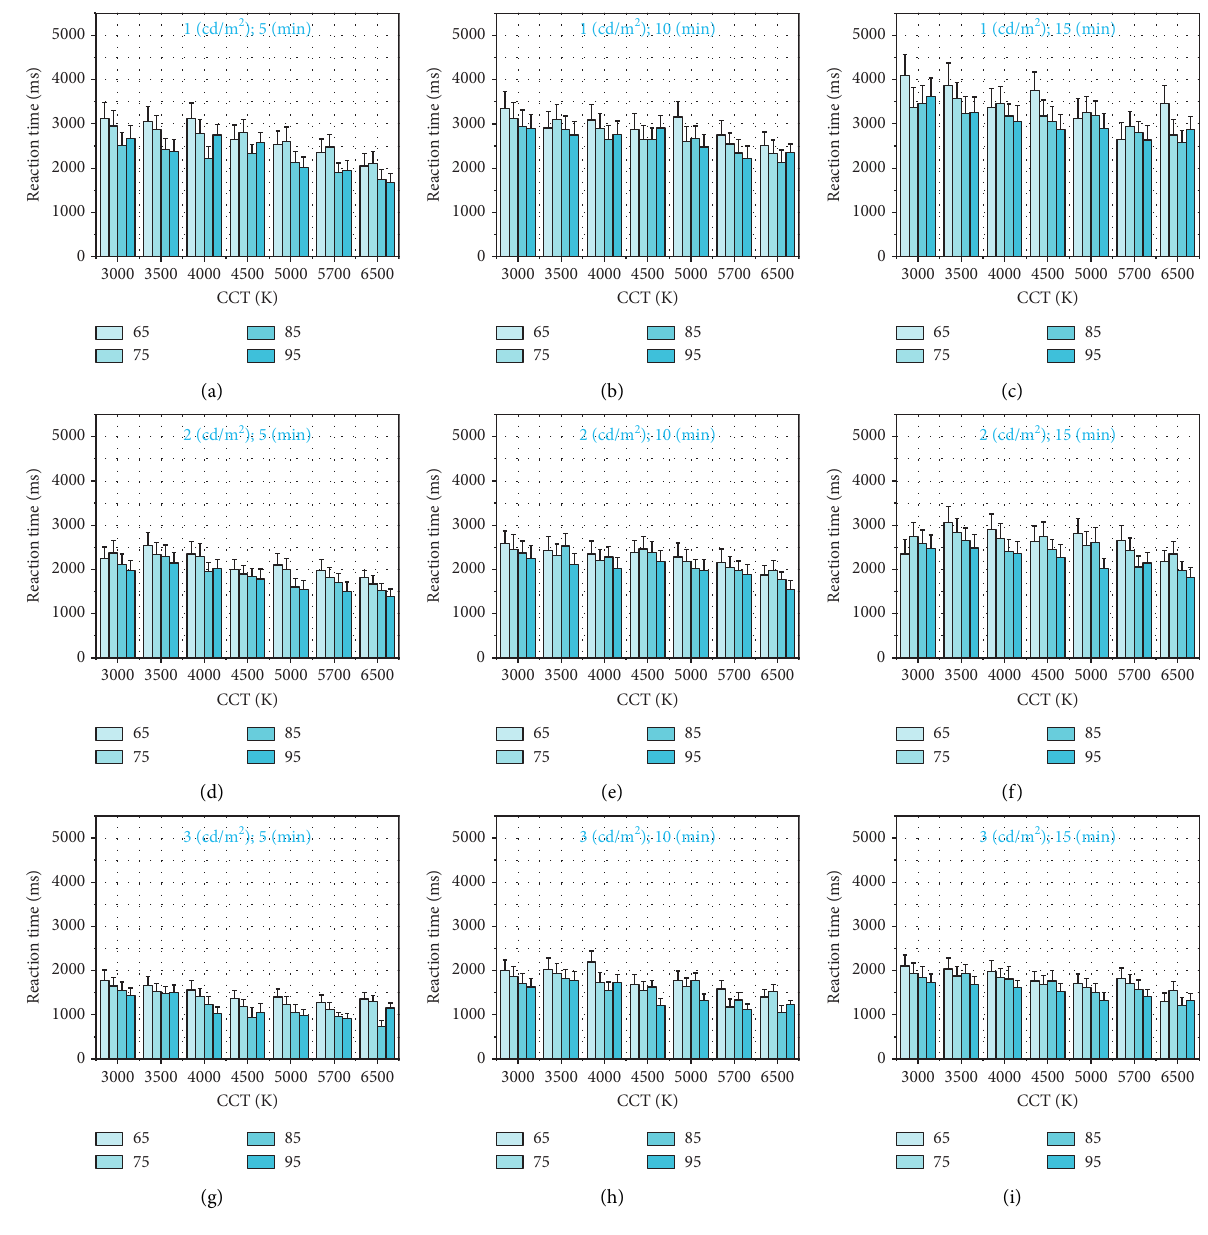
Figure 13: Average reaction time. Table 3: P value of significance analysis for the above